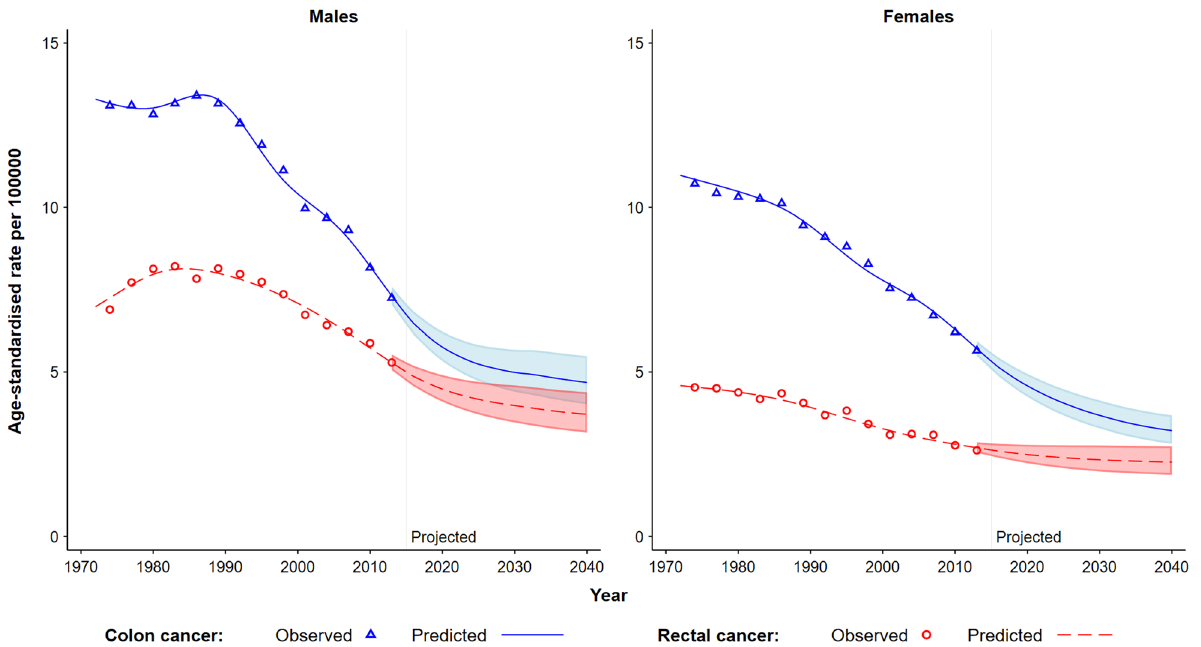
Figure 2. Observed and predicted age-standardised mortality rates for colon and rectal cancers by sex in Australia, 1972–2040. Observed and predicted mortality rates were based on the data from the New South Wales Cancer Registry. All rates are age-standardised using the Segi World standard population. The shaded area represents the 95% uncertainty